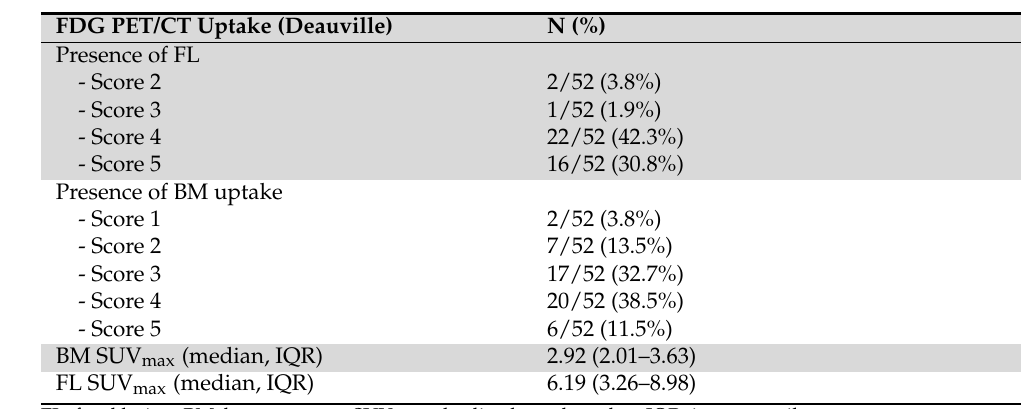
Table 3. FDG PET/CT